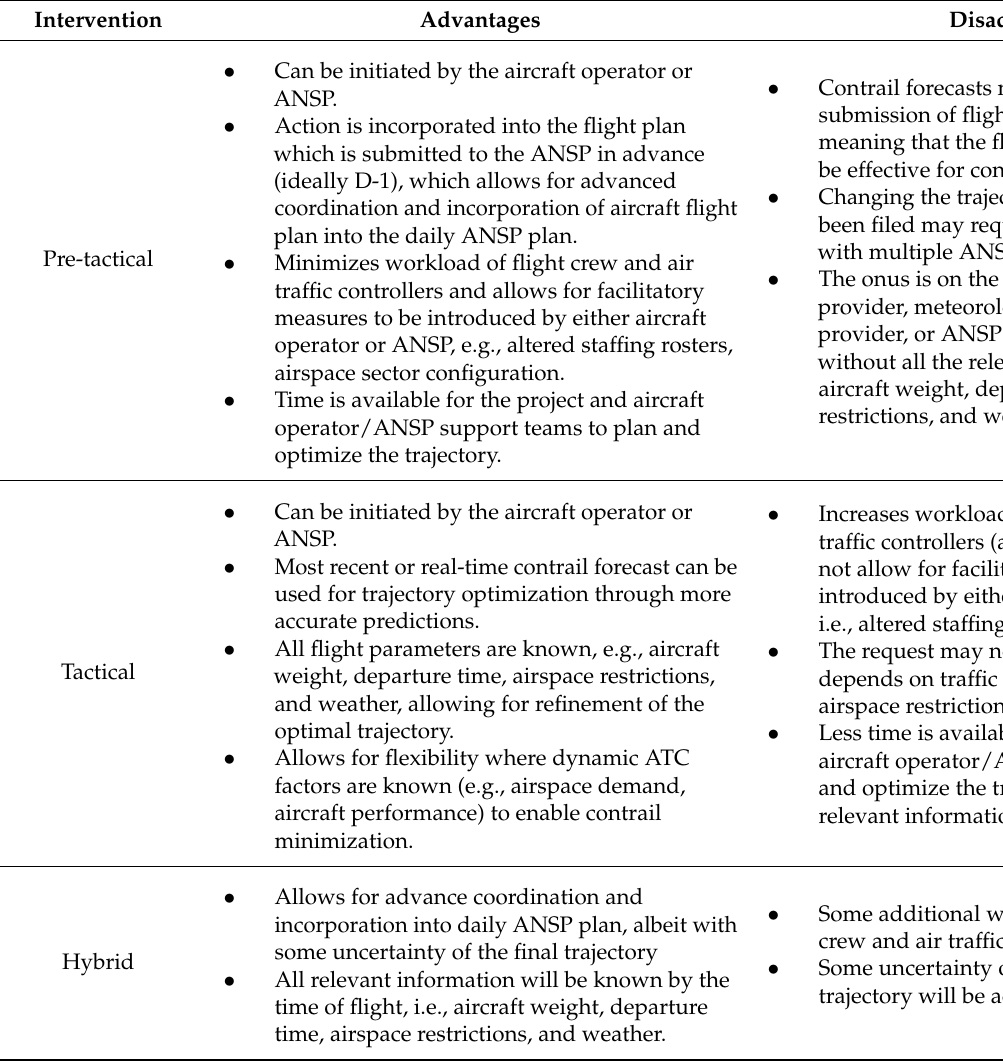
Table 1. Pros/cons for intervention